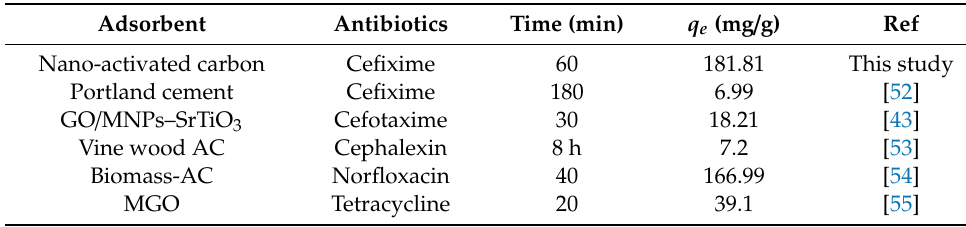
Table 4. Di ff erent ACs used for the removal of